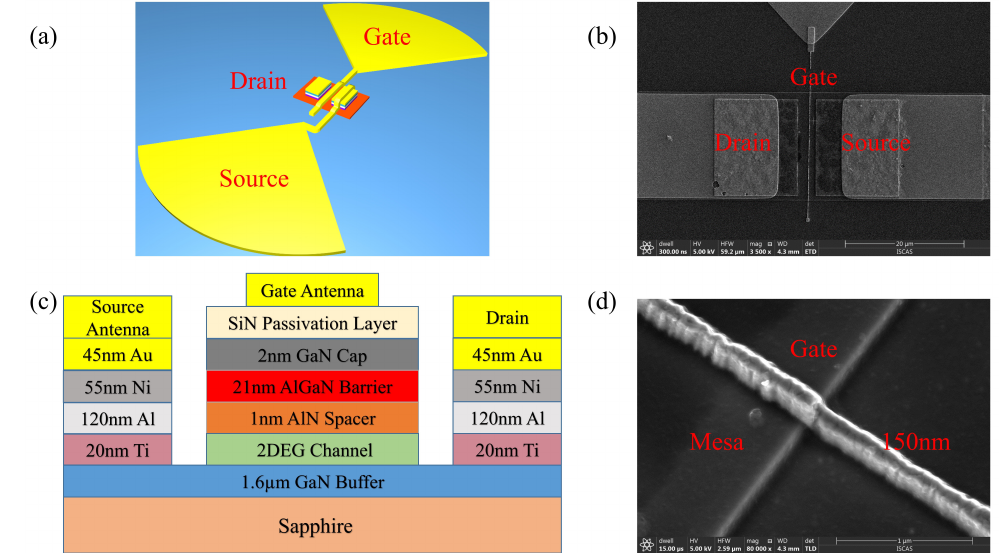
Figure 1. ( a ) Overview of the detection model. ( b ) Local diagram of THz detector at a magnification of 20 µ m. ( c ) Specific parameters of HEMT. ( d ) Partial enlarged image of gate across the mesa at a magnification of 1 µ